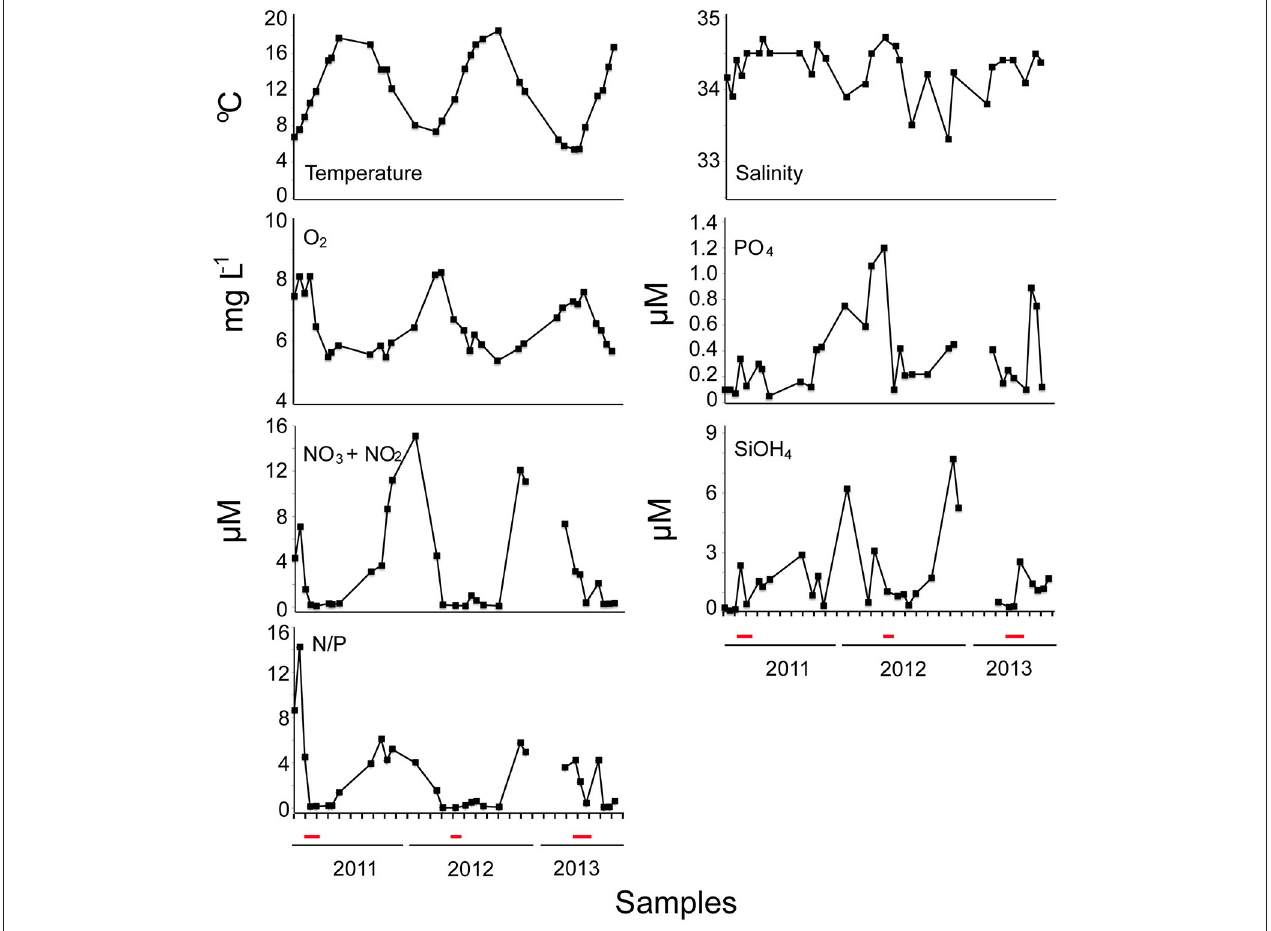
FIGURE 1 | Temporal variation of physical and chemical parameters during the study: Temperature ( ◦ C), Salinity, Oxygen (O 2 ), Phopshates (PO 4 ), Nitrates and Nitrites (NO 3 + NO 2 ), Silicates (SiO 4 ), and N/P ratio. The red line the on x-axis indicates periods of the P. globosa bloom (modified from Genitsaris et al., 2015, suppl. Fig.